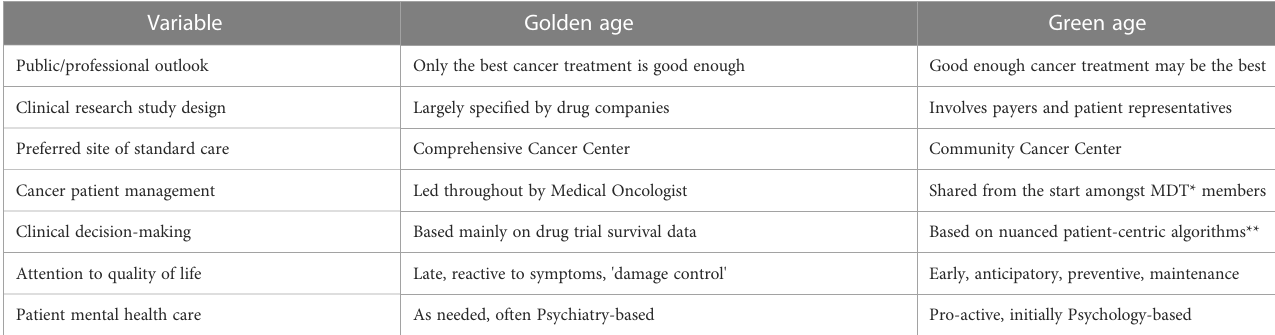
TABLE 1 Comparison of variables proposed to differ between the past (golden age) and potential future (green age) of oncology.